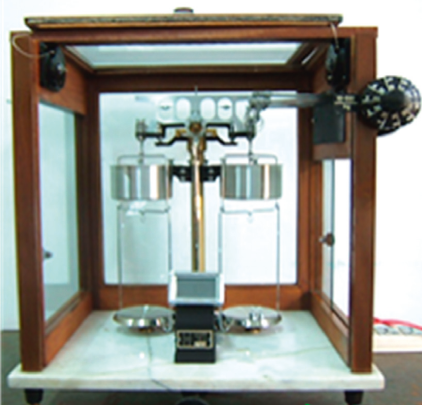
Figure 3: The TG-328B analytical balance.